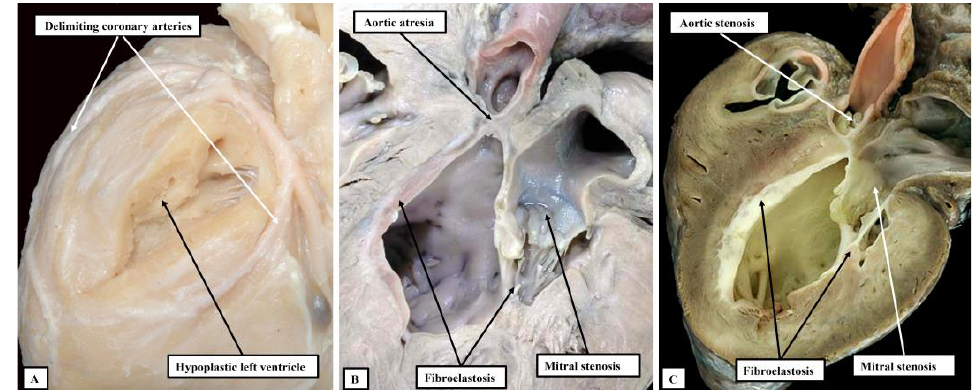
Figure 5. The images show the phenotypic features of the three subgroups of lesions that can be identified in the setting of hypoplasia of the left heart when the ventricular septum is intact. Panel ( A ) shows the grossly hypoplastic ventricle found when there is combined aortic and mitral atresia. The ventricle is no more than a slit on the diaphragmatic surface of the ventricular mass. It is found by dissecting between the delimiting coronary arteries. Panel ( B ) shows the features of aortic atresia with mitral stenosis, while panel ( C ) shows the findings with combined aortic and mitral stenosis. The left ventricle is larger in the setting of mitral stenosis, but is characterised by its dense fibroelastotic lining.